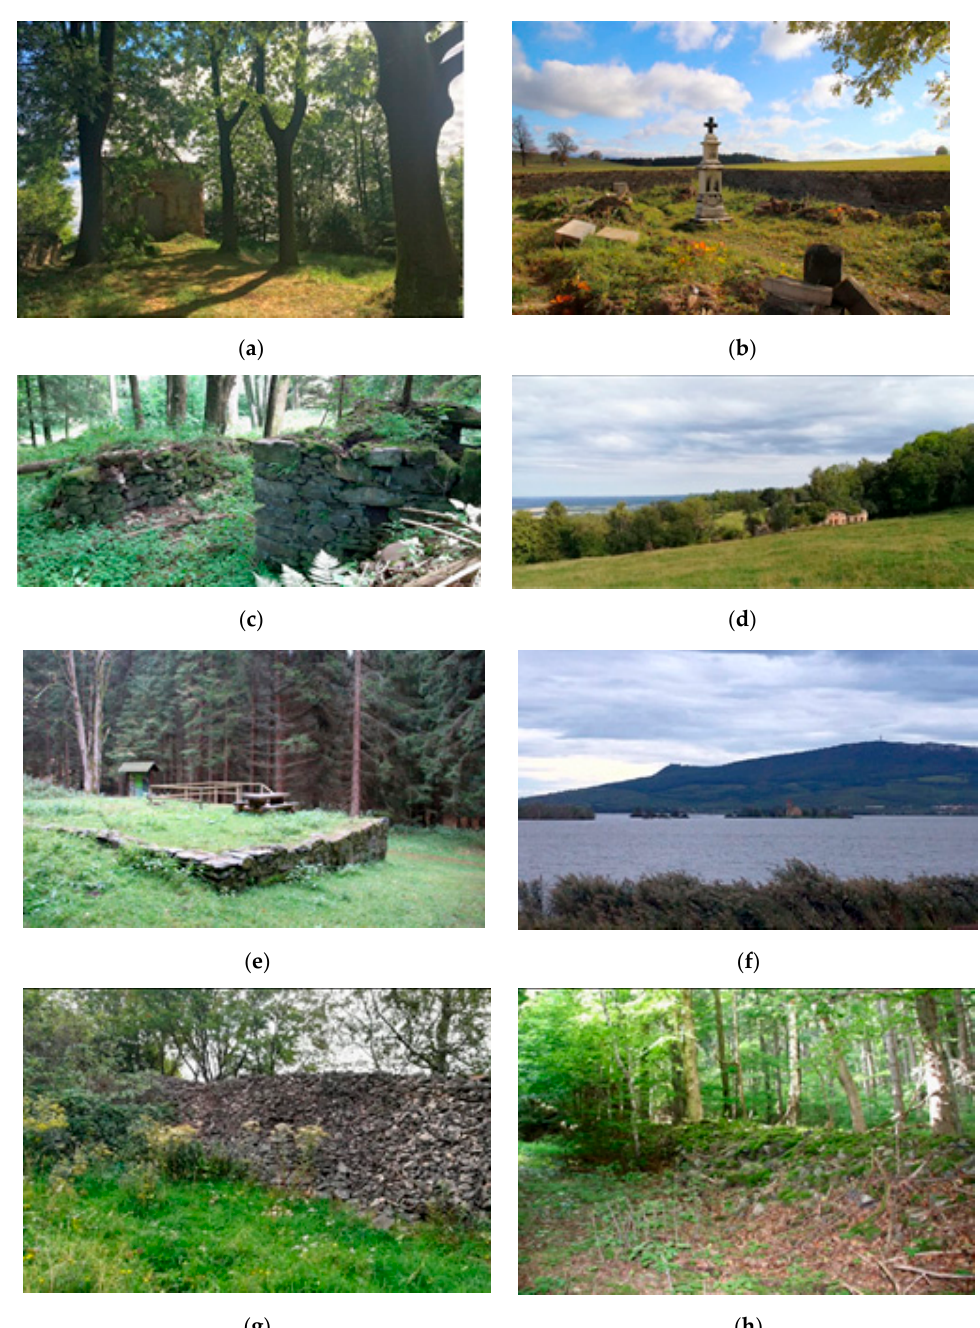
Figure 4. Case study of H ř ibová (Pilzberg in German, a settlement of Vl č ice municipality): aerial survey images from ( a ) 1937, ( b ) 1964 and ( c ) 2019 Source: https://ags.cuzk.cz/archiv/ accessed on 21 March 2004, ( d ) photograph of the current landscape (the authors).